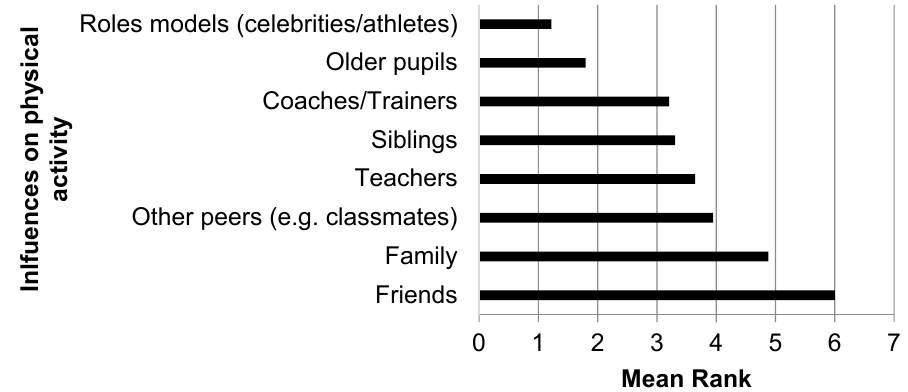
Figure 2. Main influences † on physical activity in younger female pupils (11–14 years) from a schools’ perspective. † Responding schools asked to rank the main influences from 1 to 8 (where 1 is the least influential and 8 is the most influential).